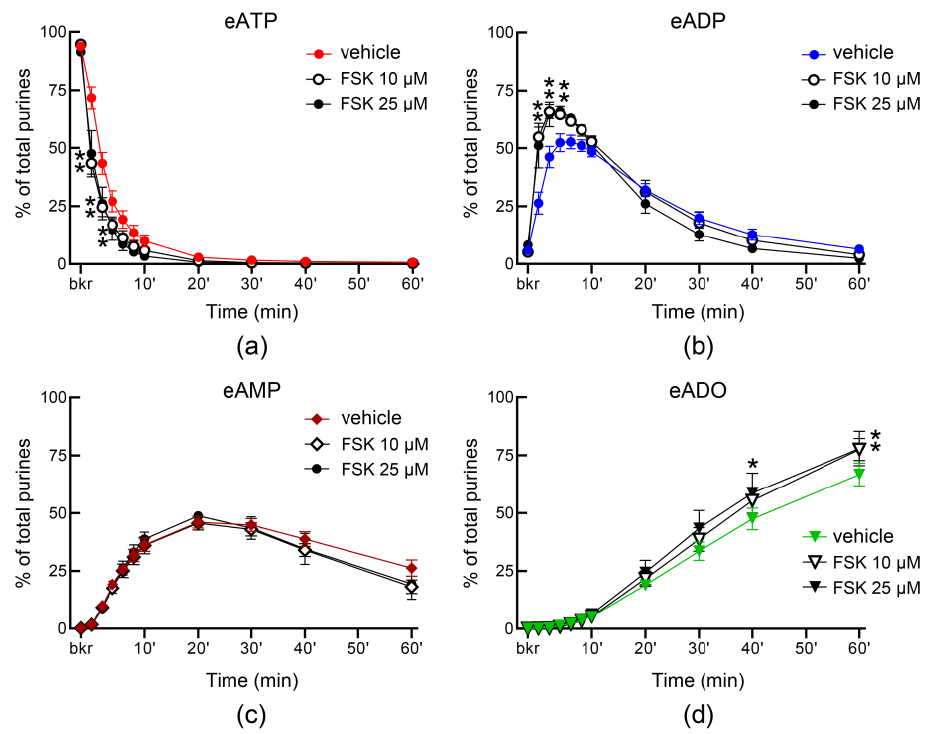
Figure 7. Effect of forskolin (FSK) on the hydrolysis of eATP by soluble enzymes released in bladder lumen during filling. Decrease of eATP ( a ) and increase in eADP ( b ), eAMP ( c ), and eADO ( d ) after addition of eATP in ILS from bladder preparations filled with vehicle (DMSO 0.1%, n = 7) or FSK ( n = 4 each); n , number of bladder preparations. Note that the decrease of eATP and the formation of eADP and eADO were enhanced in the presence of FSK. Asterisks denote significant differences from vehicle controls. * p < 0.05, ** p < 0.01. 2 way ANOVA with Tukey’s multiple comparisons tests.